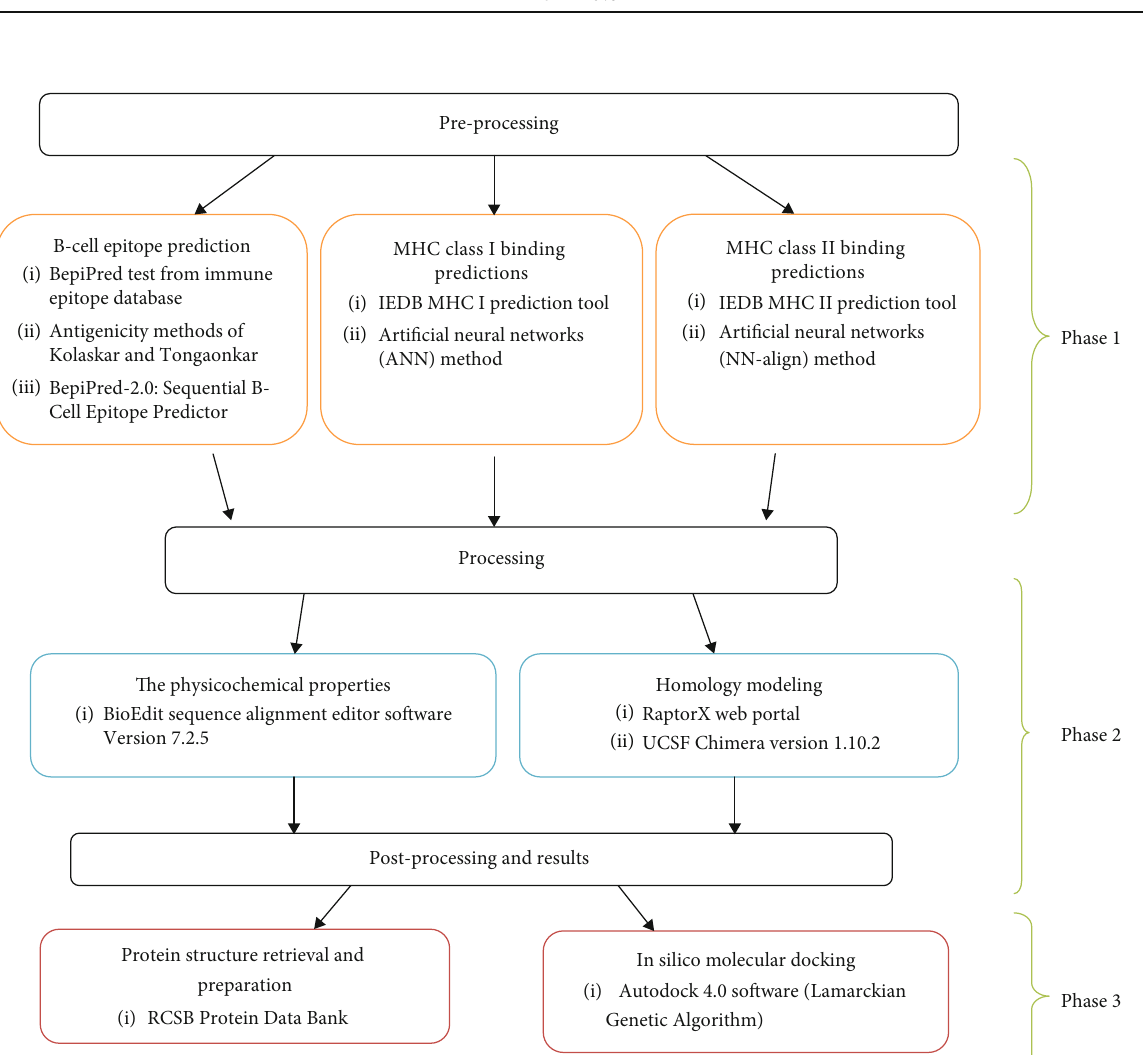
Figure 4: The three phases of Materials and